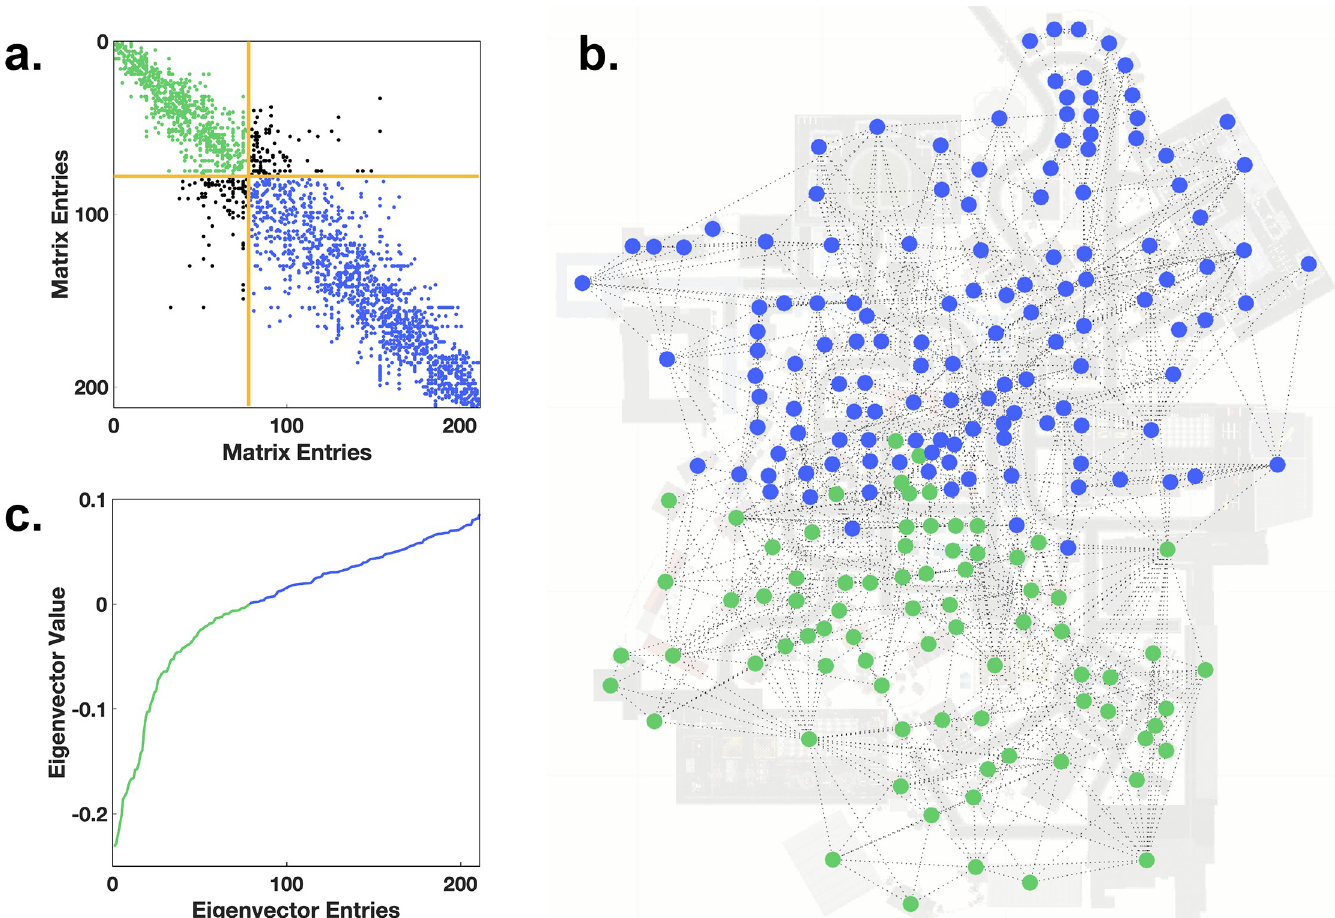
Fig 4. Graph partitioning. (a) The sparsity pattern of the graph’s adjacency matrix sorted by the entries in second smallest eigenvector. Color coded into edges between nodes of one cluster (green), edges between nodes of the other cluster (blue), edges between nodes of the two clusters (black) and a distinction between the clusters (yellow). (b) The two clusters are displayed onto the map of participant 35. (c) The second smallest eigenvector of the Laplacian matrix is sorted ascendingly and color coded into two clusters.